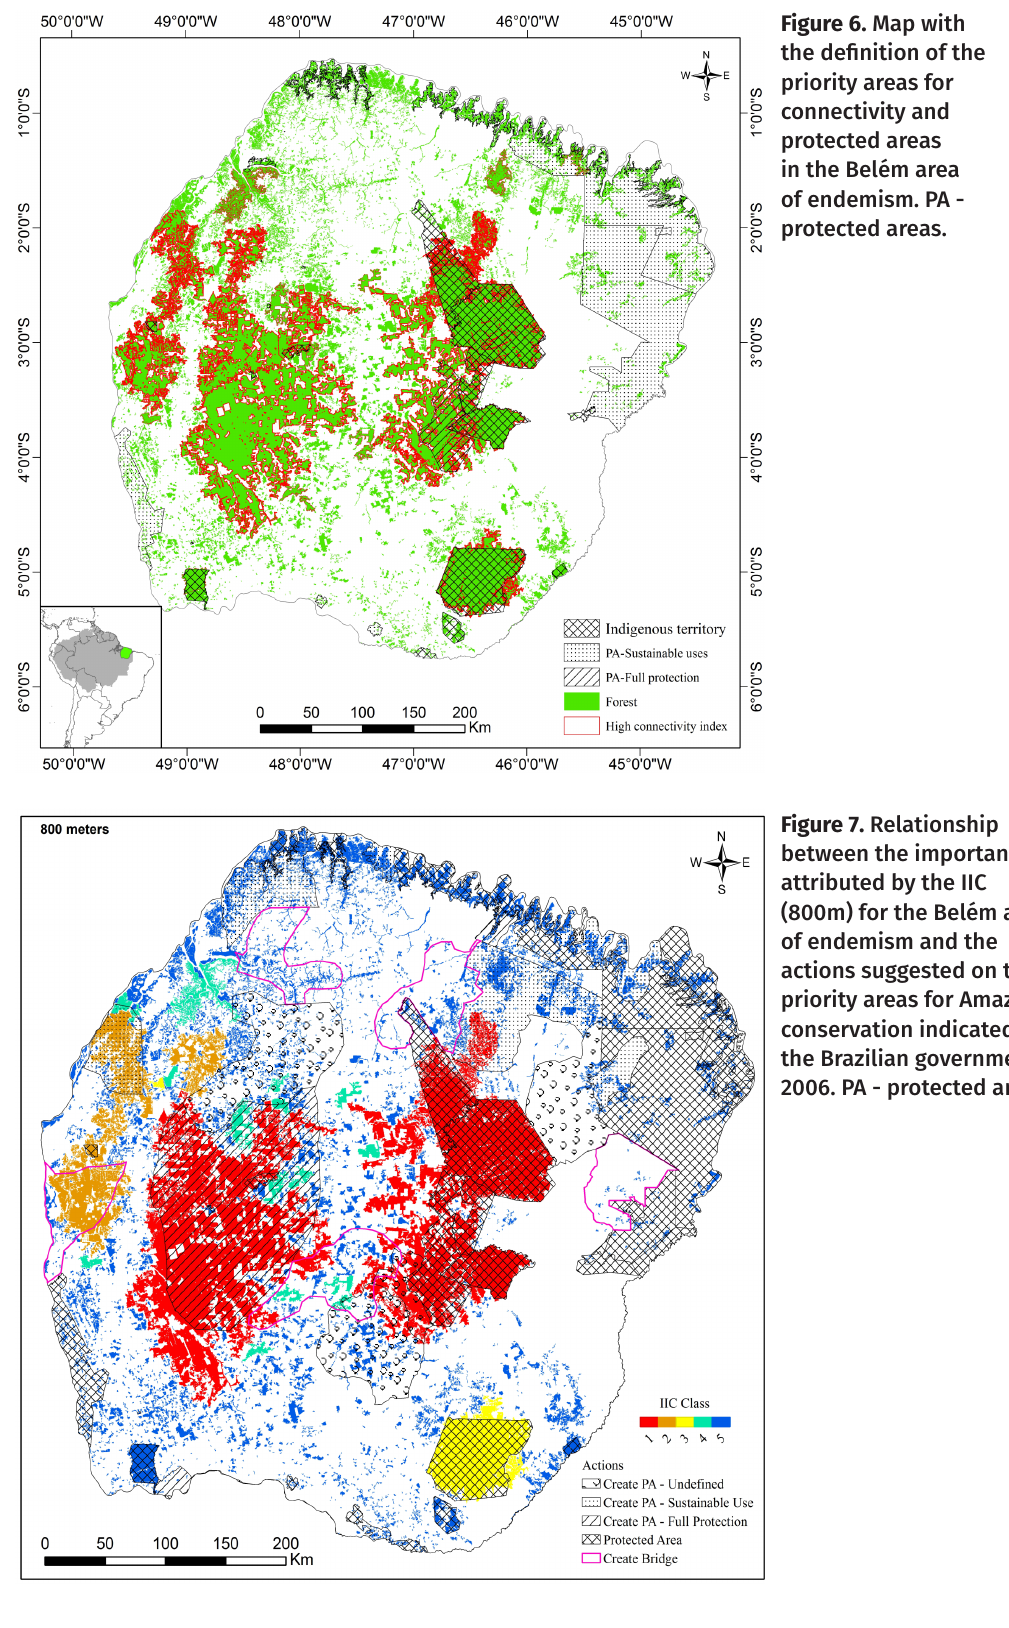
Figure 6. Map with the definition of the priority areas for connectivity and protected areas in the Belém area of endemism. PA - protected areas.